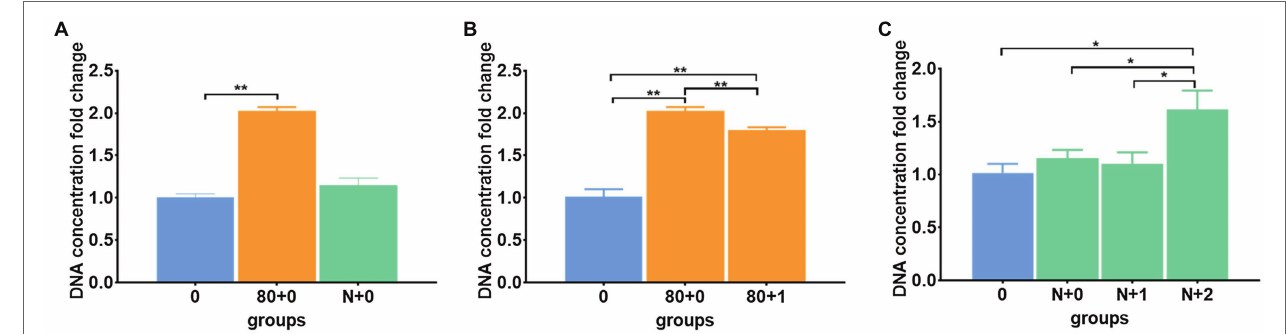
FIGURE 3 | Different freezing patterns affected DNA extraction efficiency. (A) The DNA extraction efficiencies in the immediate freezing groups; (B) The DNA extraction efficiencies in the immediate and gradient freezing groups when samples were frozen at − 80 ° C; (C) The DNA extraction efficiencies in the immediate and gradient freezing groups when samples were frozen in liquid nitrogen. The corresponding data were shown in Supplementary Table S4 . * P < 0.05, ** P < 0.01.